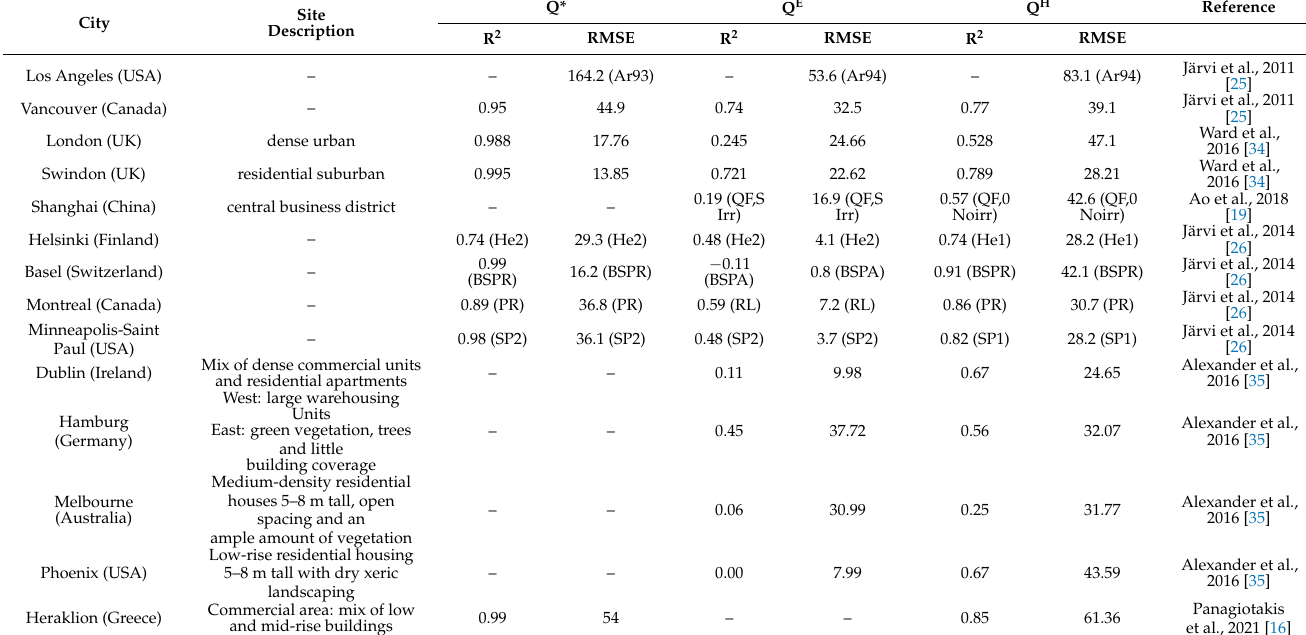
Table 2. SUEWS evaluation results for net all-wave radiation, turbulent latent, and sensible heat flux for different sites. Text in brackets indicates the code name for a specific site/experiment as presented by the authors in the literature. RMSE stands for Root Mean Square